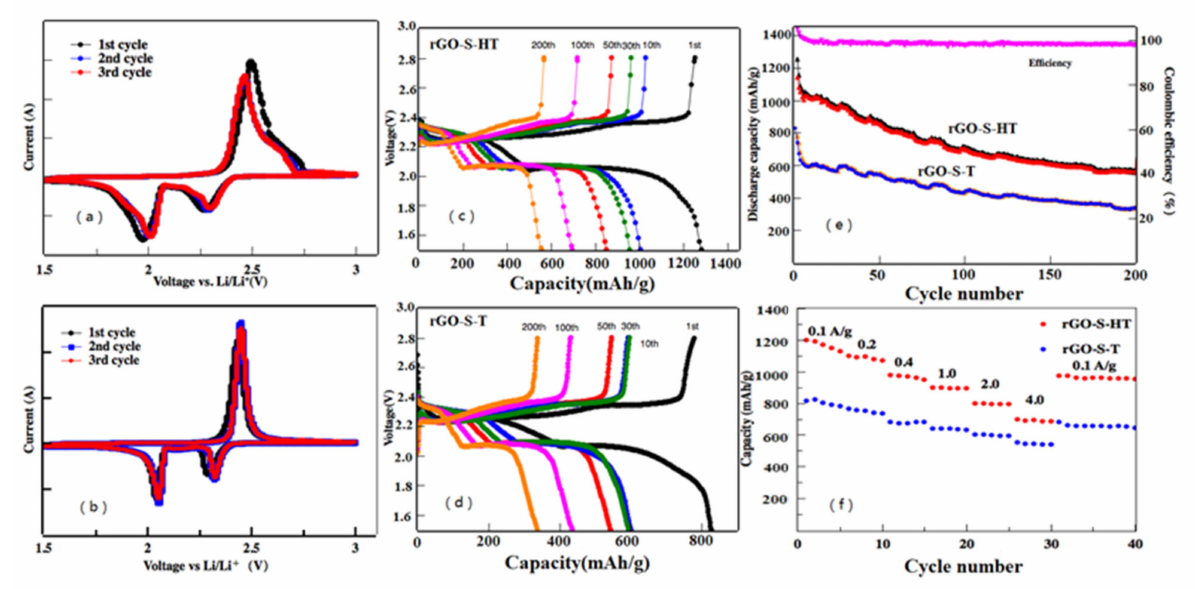
Figure 5. ( a , b ) Cyclic voltammograms (CVs) of the rGO-S-HT and rGO-S-T cathode at 0.1 mV s − 1 with a potential window of 1.5–3 V vs Li + /Li, ( c , d ) Discharge/charge voltage profiles of the rGO-S-HT and rGO-S-T cathode for the 1st, 50th cycles at 0.1 A g − 1 , ( e ) Cyclic performance of the rGO-S-HT and rGO-S-T cathode at 1.0 A g − 1 , ( f ) Rate performance of the rGO-S-HT and rG-S-T cathode at different current densities from 0.1 to 4.0 A g − 1